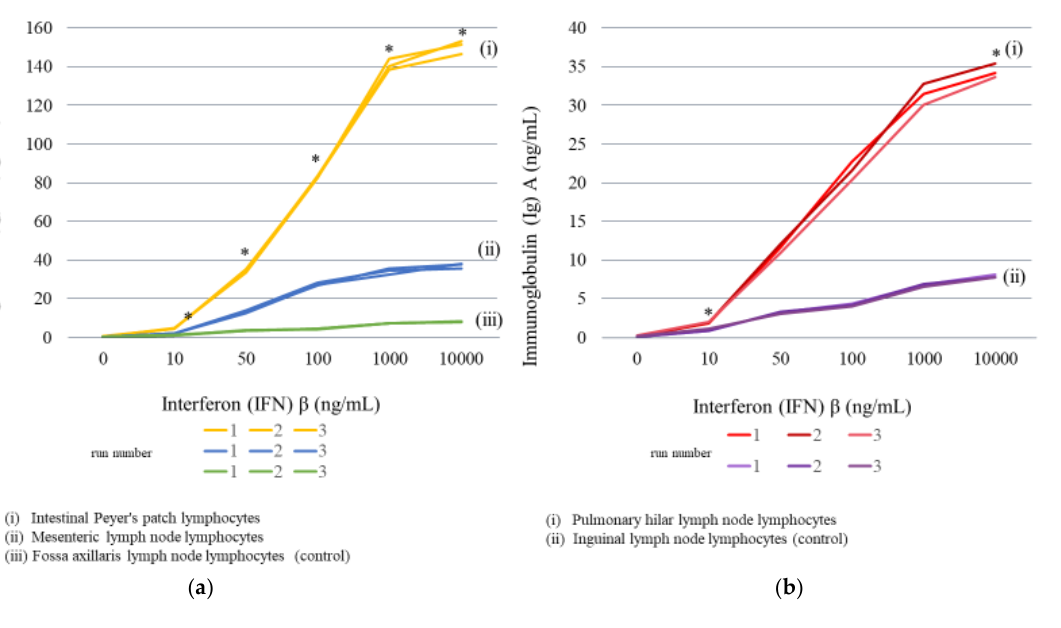
IFNβ resulted in peak IgA levels, 35.7–38.3 ng/mL (average 37.2 ng/mL) (Figure 4a and Table 5). Conversely, lymphocytes of fossa axillaris lymph nodes, which are non-regional piratory regional lymph node lymphocytes; the IgA level upon addition of 50 ng/mL of lymph nodes of the gastrointestinal tract, showed an extremely small IFNβ-induced in- IFN β was 3.1–3.3 ng/mL (average = 3.2 ng/mL), which represented approximately 33 creases in IgA production. However, the rate of increase was much lower (virtually no times the IgA level in the absence of IFN β (0.1–0.2 ng/mL, average = 0.1 ng/mL). The IgA increase was noted) compared with that of the gastrointestinal regional lymph nodes; the level reached 7.8–8.1 ng/mL (average = 7.9 ng/mL) upon addition of 10,000 ng/mL of IgA level without addition of IFNβ was 0.2 ng/mL (average 0.2 ng/mL), while the addition of 10,000 ng/mL of IFNβ resulted in an IgA level of <8.1 to 8.4 ng/mL (average = 8.2 ng/mL) IFN β . However, the rate of increase was lower than that for pulmonary hilar lymph node (Figure 4a and Table 5). (respiratory regional lymph node) lymphocytes (Figure 4b and Table 5).